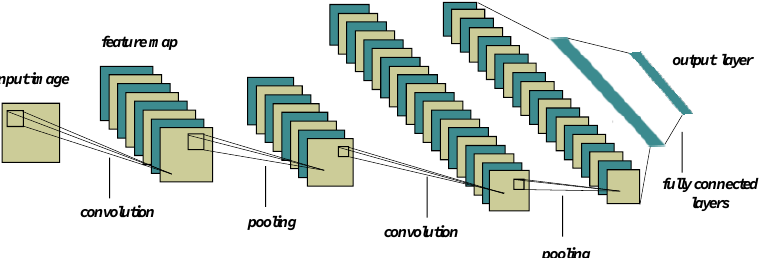
Figure 5. The typical architecture of a CNN.